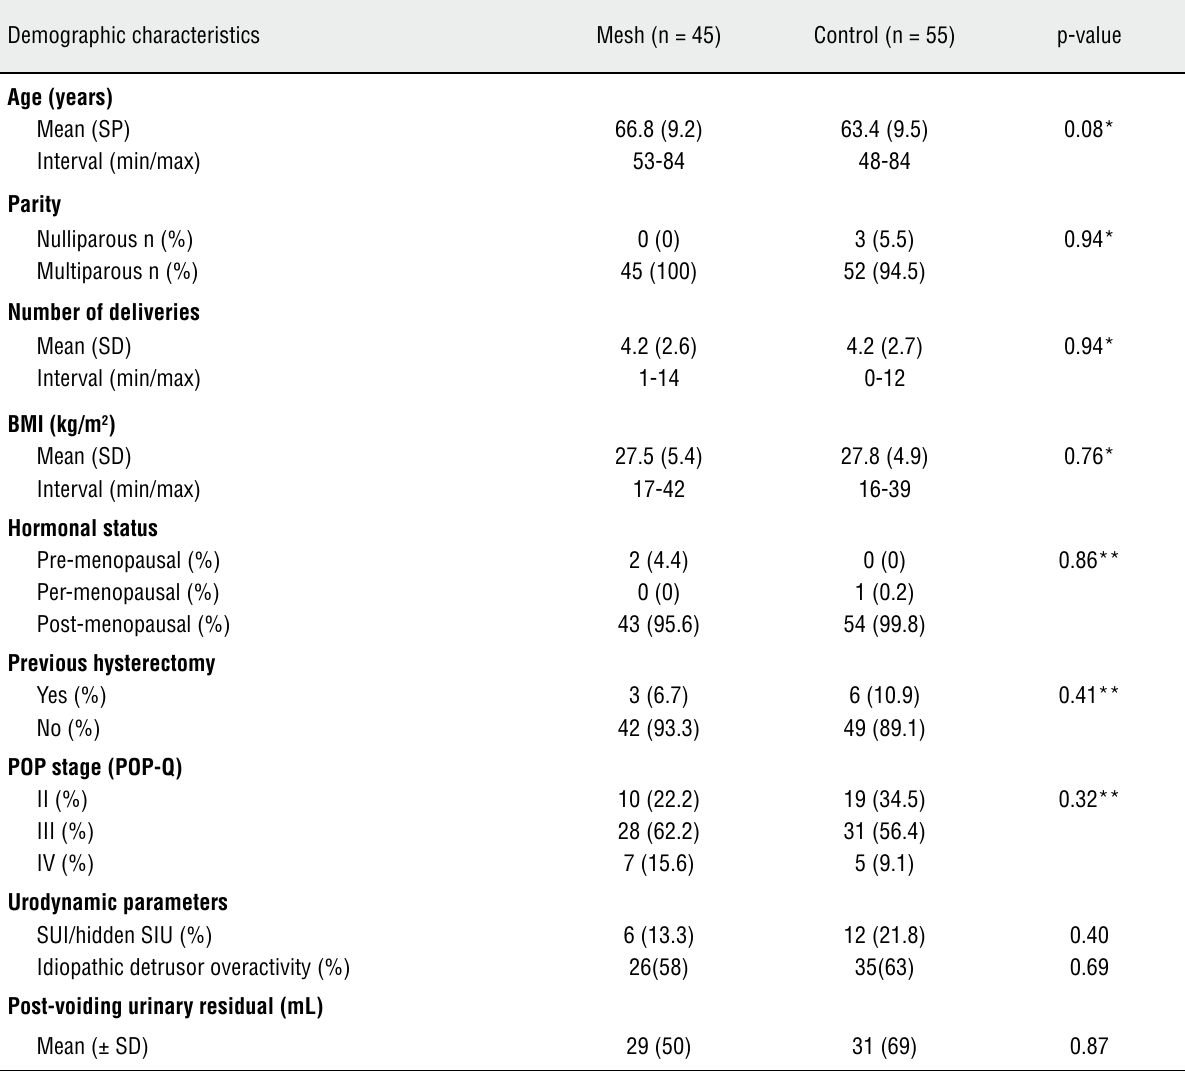
Table 1 - Demographic characteristics of the Mesh and Control groups during preoperatory period (n=100) Demographic